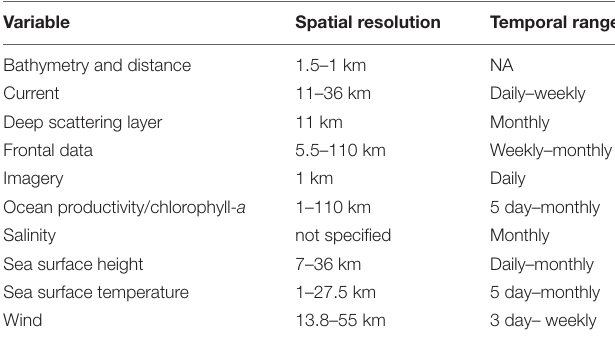
TABLE 4 | Variable categories and ranges of spatial and temporal resolution from the literature